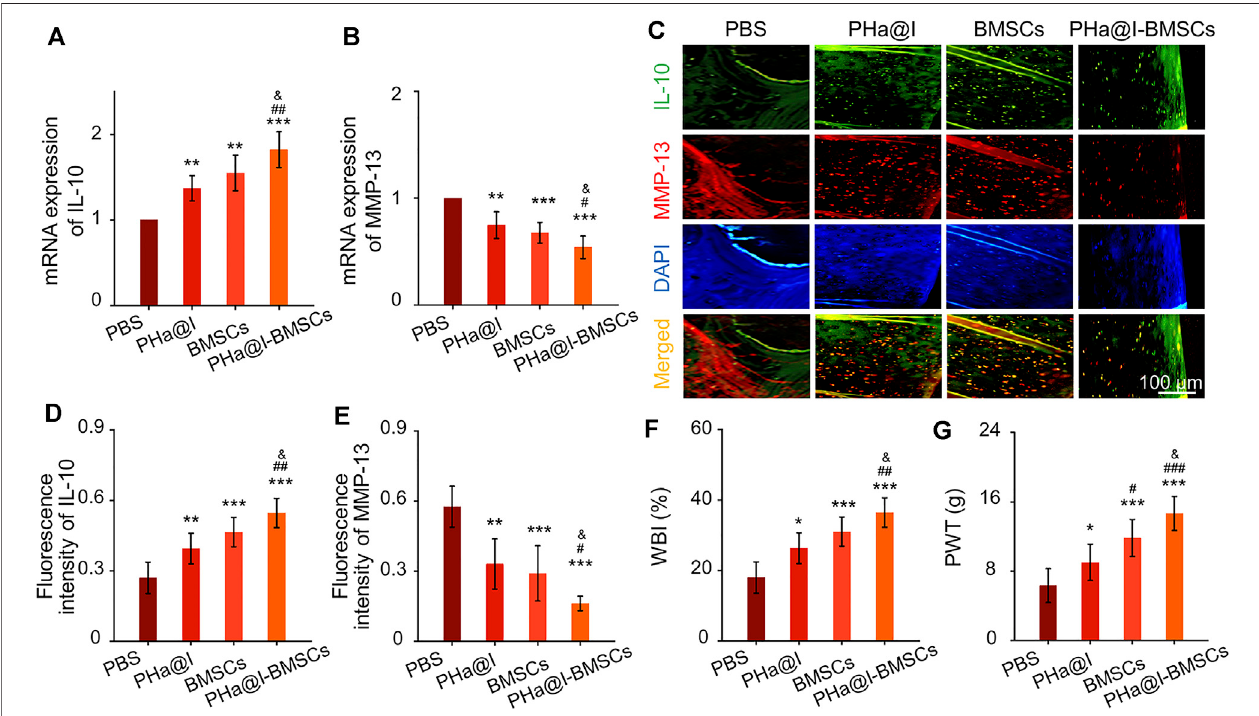
FIGURE 8| Intra-articular injection ofBMSCsincorporating PHa@I hydrogels inhibitin fl ammation and relievepain in OA. (A,B) RT-qPCRanalysis IL-10 and MMP- 13 incartilage. (C) Representative double immuno fl uorescence imagesofIL-10andMMP-13. ( D,E) Quantitative analysisof fl uorescence intensityofIL-10andMMP-13 in immuno fl uorescence staining. (F) Weight-bearing capacity was calculated by weight-bearing index (WBI). (G) Paw withdrawal threshold (PWT) was measured to test mechanicalallodynia(* p < .05,** p < .01,and*** p < .001comparedwiththePBSGroup; # p < .05, ## p < .01,and ### p < .001comparedwiththePHa@IGroup; & p < .05 compared with the BMSC Group, n =